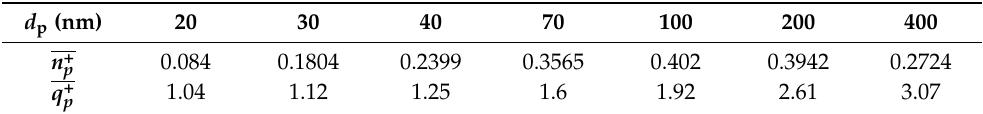
Table A2. Table A2. From the values in Table A1 calculated average normalized fraction of positive-charged (cid:0) (cid:1) d p particles n + p and their average charge number q + p